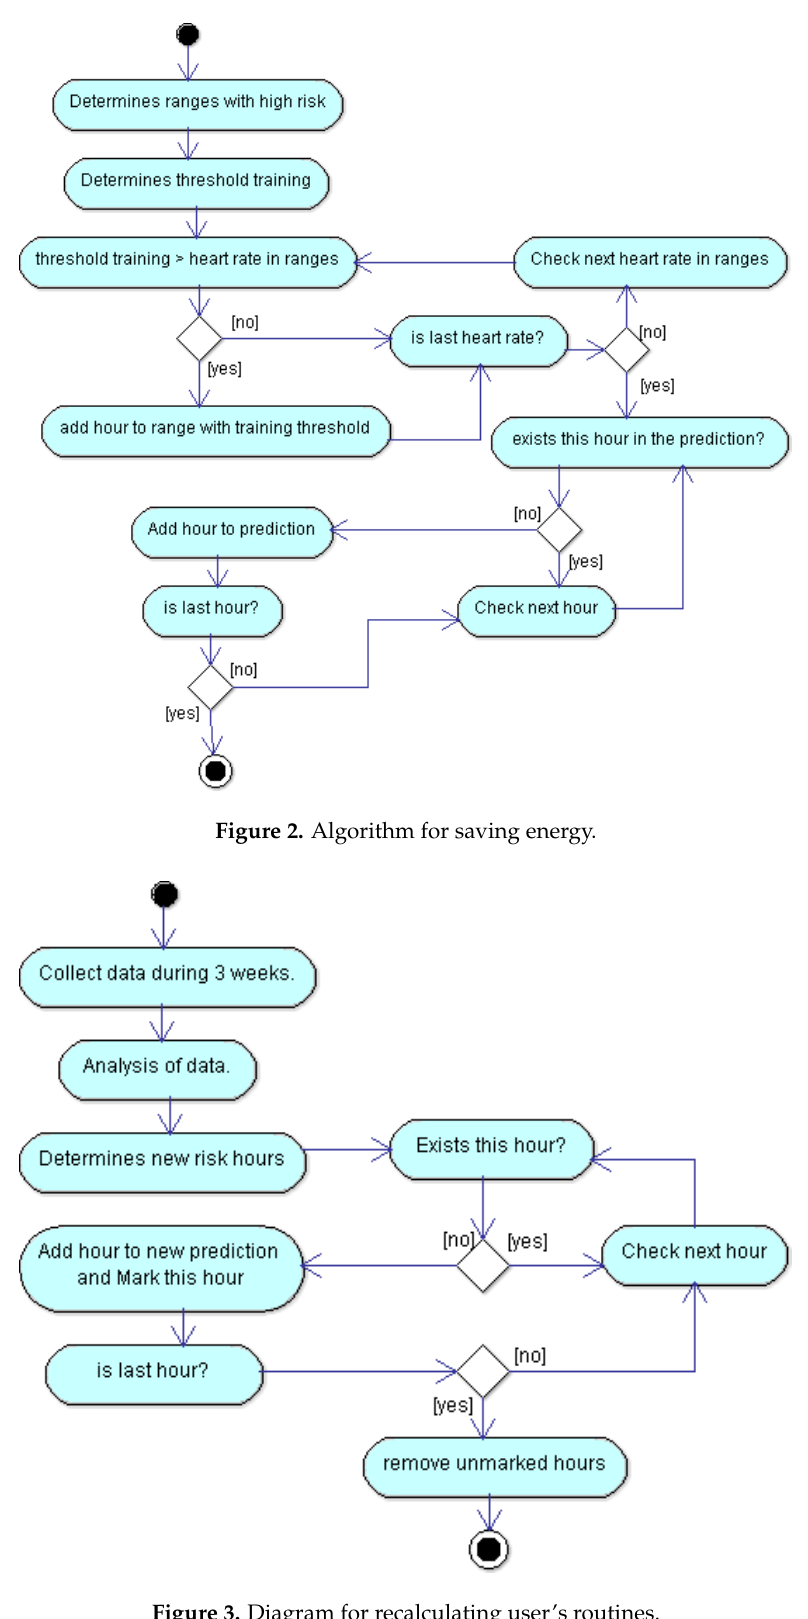
Figure 3. Diagram for recalculating user’s